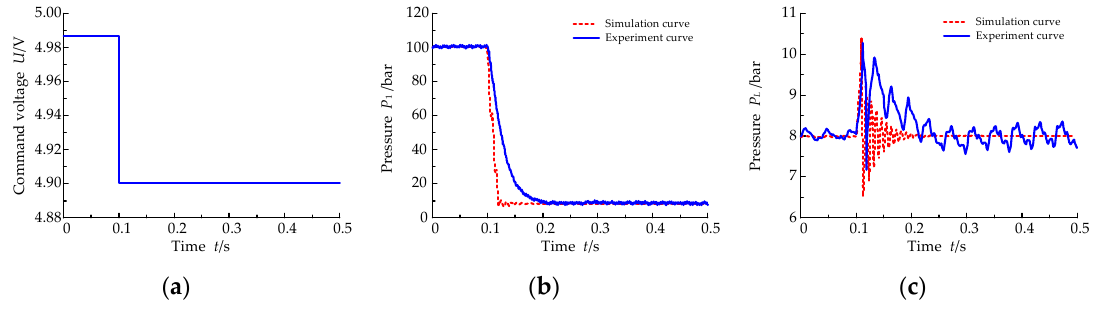
Figure 13. The experiment curves under the step pressure-relief rule. ( a ) Eccentric magnitude; ( b ) Working cylinder pressure; ( c ) Relief-pipe pressure.